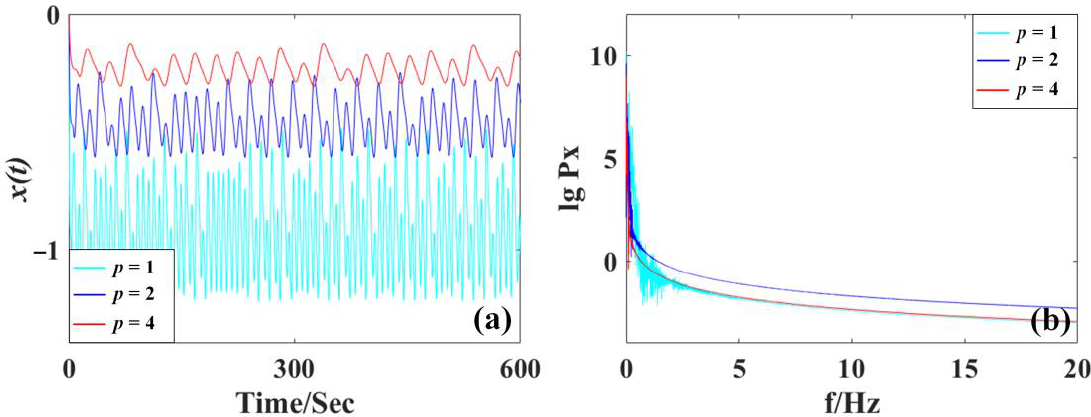
Figure 1. Waveform and frequency spectra of x from the system (5) with a = 0.5, b = 0.6, c = 1.2 and initial values of (0, 1.3, 1): ( a ) chaotic signal x ( t ), ( b ) frequency spectra of the signal x ( t ).